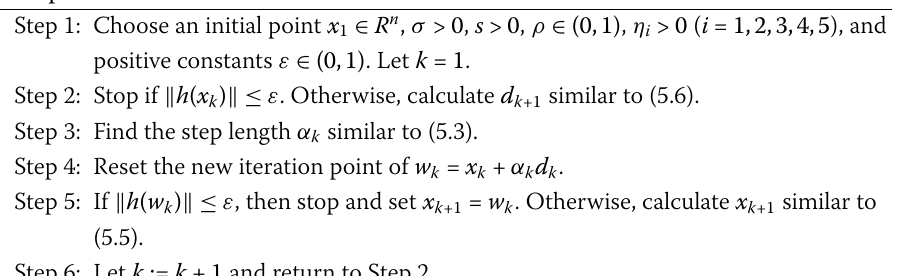
Algorithm 5.1 Modified three-term conjugate gradient algorithm for large-scale nonlin- ear